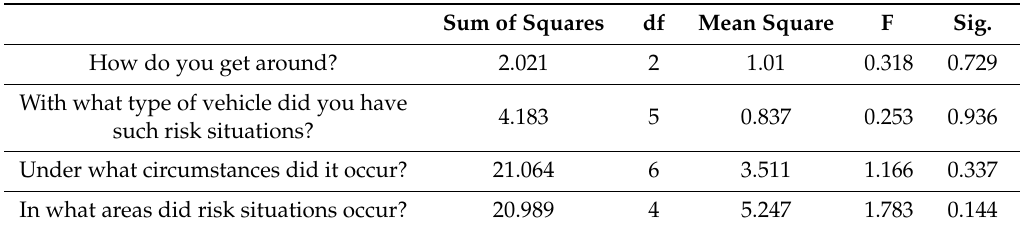
Table 3. Summary of ANOVA analysis of the significance of the characteristics of risk situations on the perception of risk. Sum of Squares